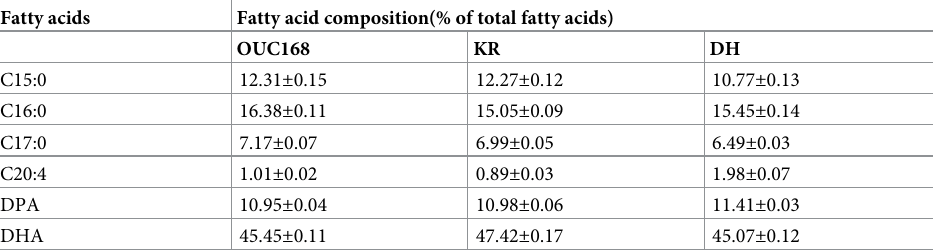
Table 3. Fatty acid composition of A . limacinum OUC168, KR and DH. All data are expressed as means ± SD (n = 3). Fatty